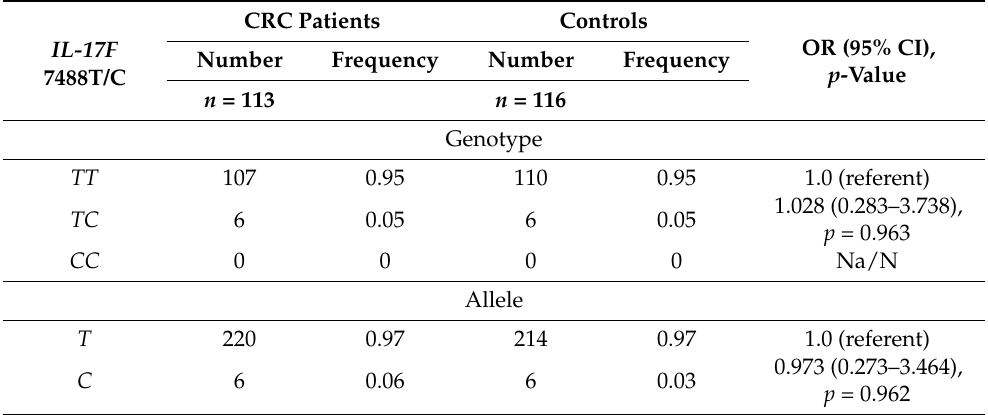
Table 5. Genotype and allelic frequencies among CRC patients and control individuals according to the IL17F 7488 C/T polymorphism.